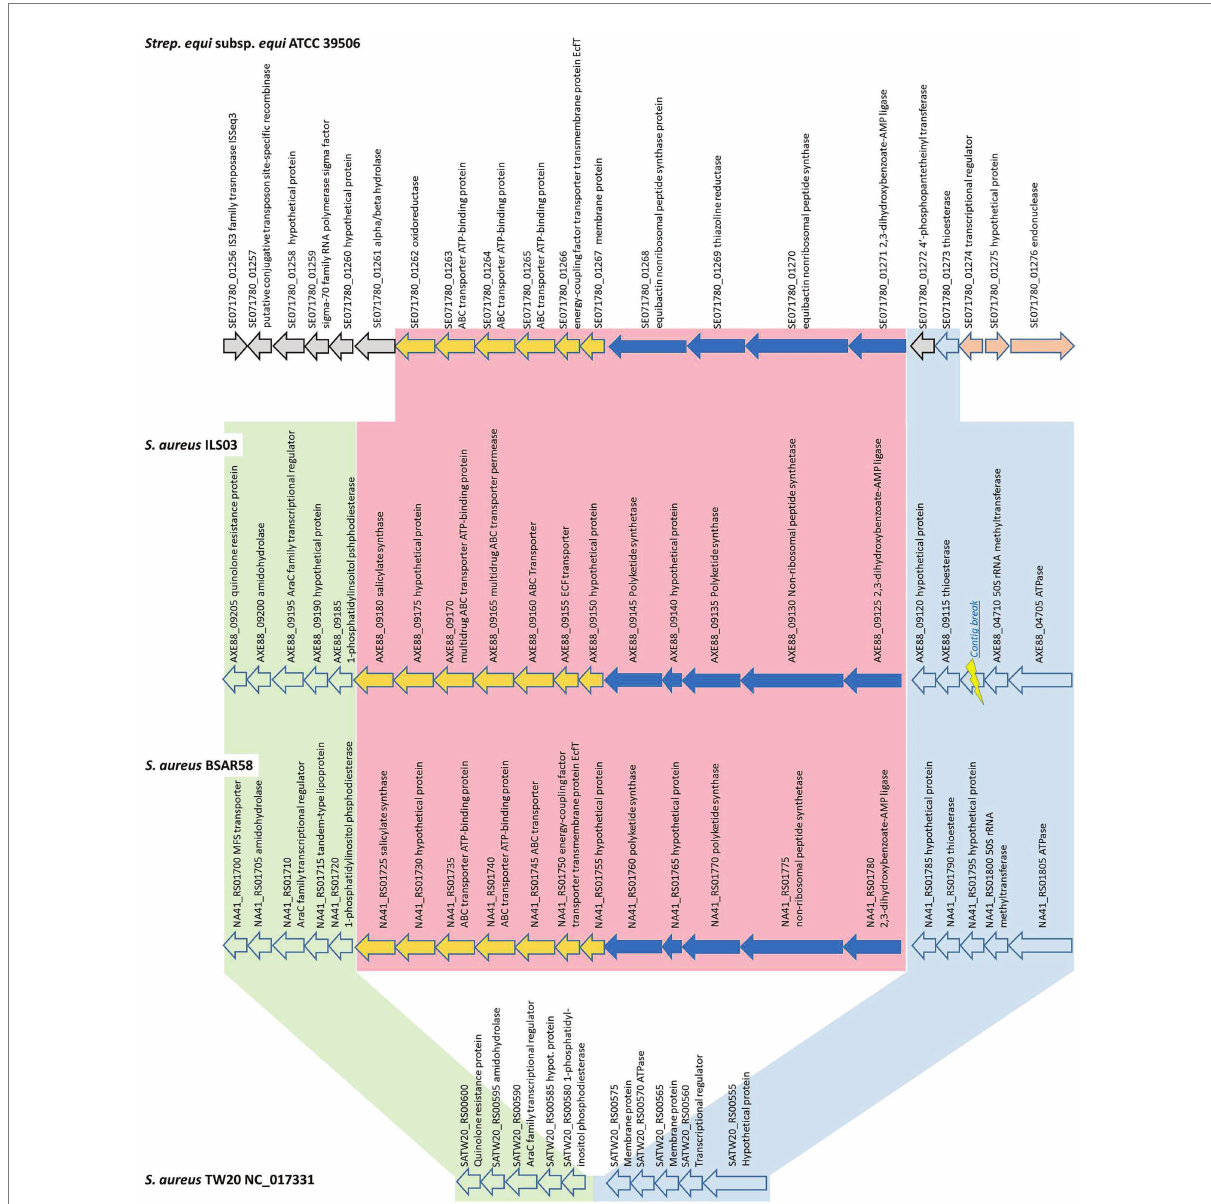
FIGURE 3 Detailed schematic overview of the putative yersiniabactin-encoding operon and short flanking regions shared among yersiniabactin-carriers (ILS-03 and BSAR58) and non-carrier (TW20) S. aureus strains as well as S. equi subsp. equi ATCC 39506 as closest other